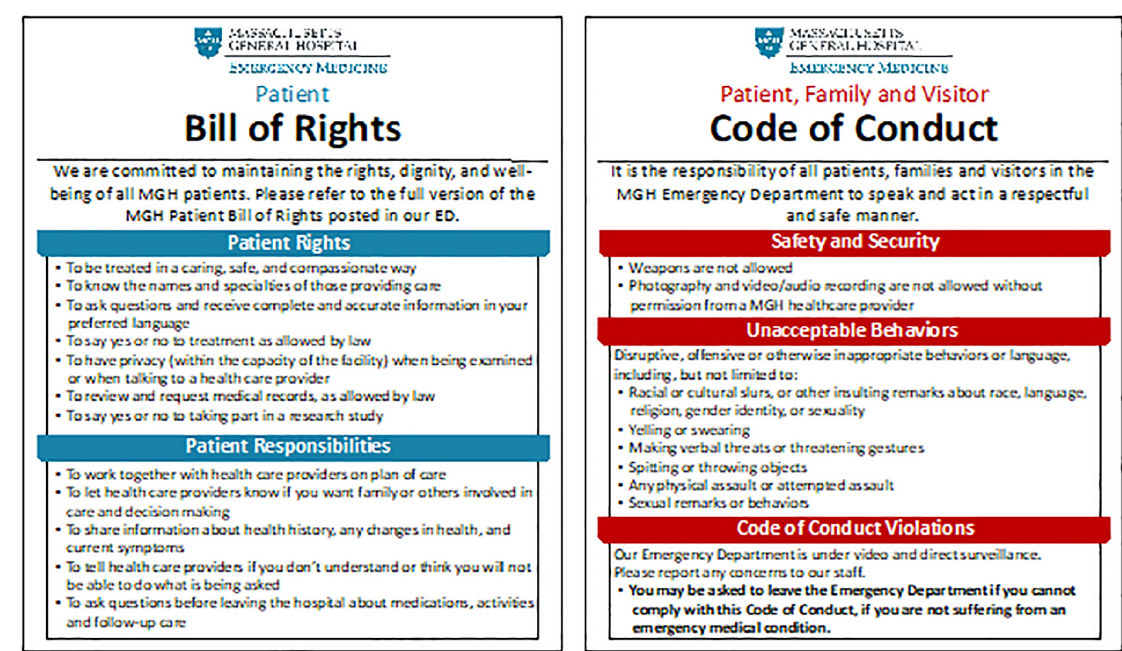
Figure. Code of Conduct, Massachusetts General Hospital Emergency Department. Used with permission from the Department of Emergency Medicine, Massachusetts General